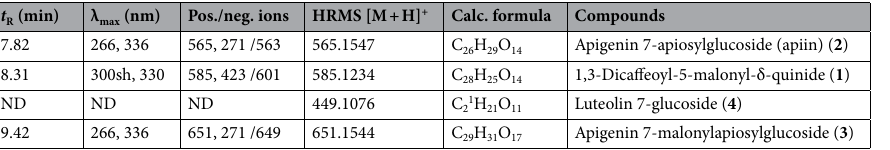
Table 1. UHPLC-MS and HRMS data of main phenolics in methanolic extracts of chervil, Anthriscus cerefolium . Characteristic ions ( m/z ) from mass detection is listed with the pseudomolecular ions ([M + H] + or [M-H] − ) followed by fragments ions included those of the aglycone moieties. Nd not